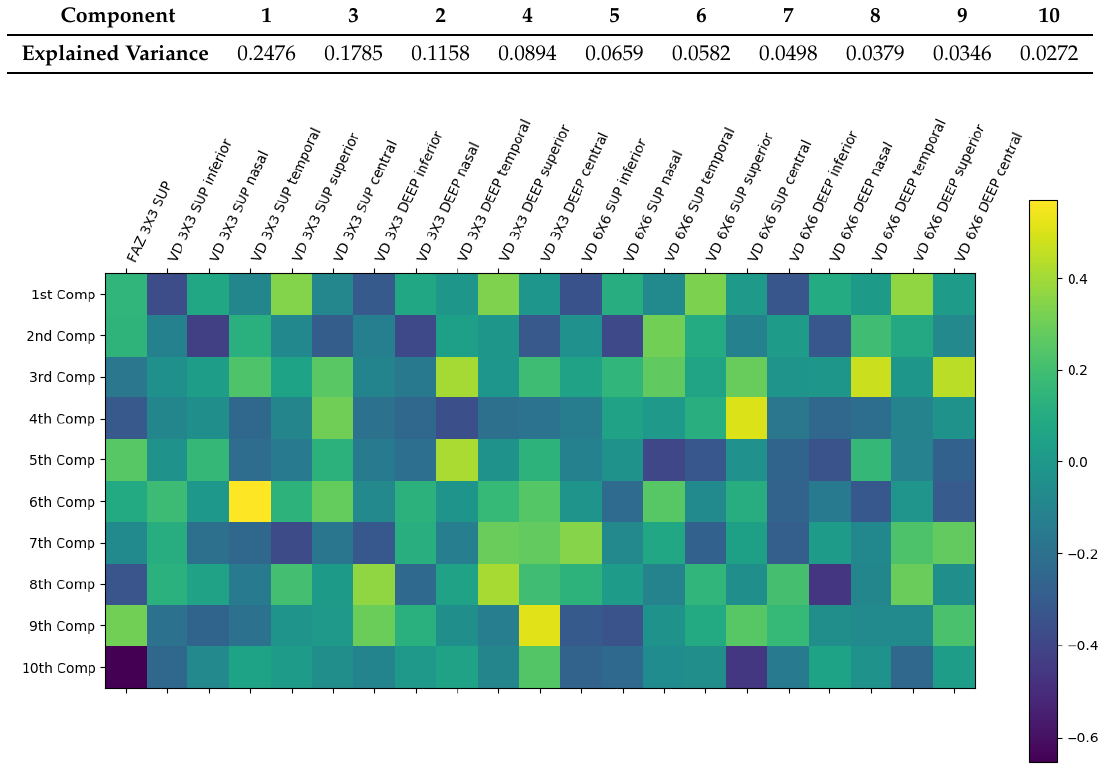
Table 2. Explained variance of each extracted PCA component.